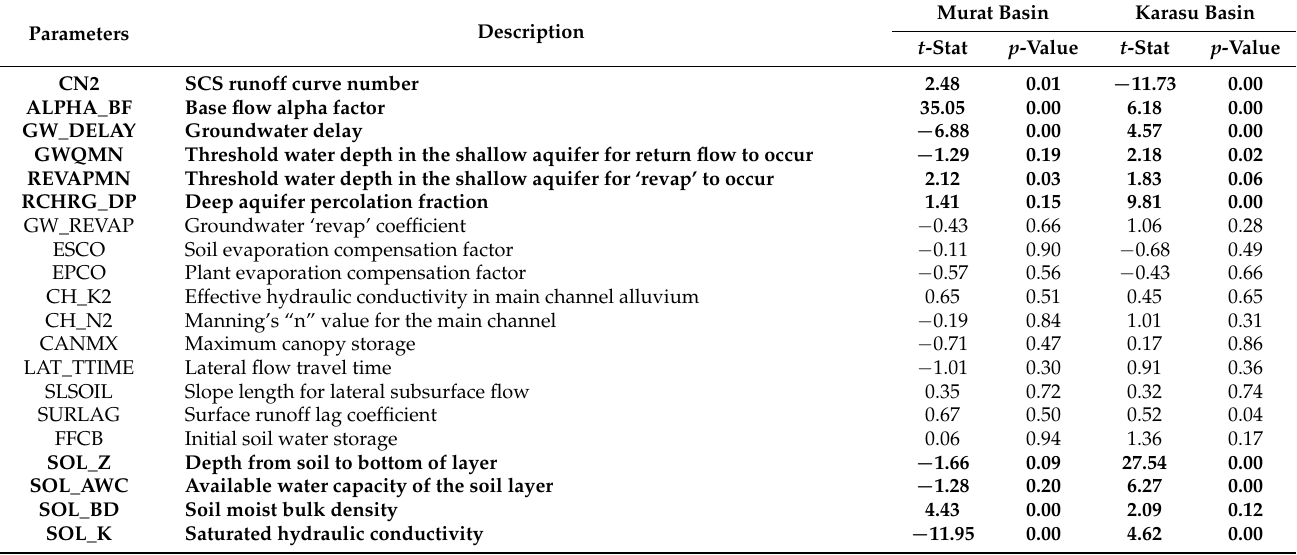
Table 5. Statistical results of global sensitivity